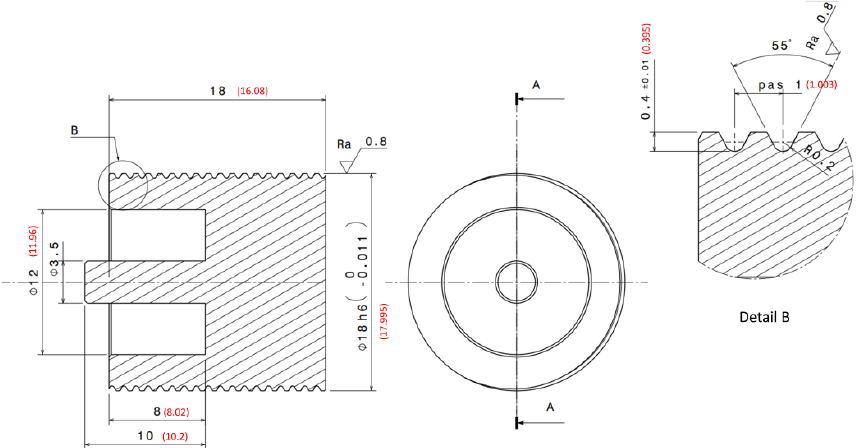
Figure A1. Mechanical drawing of the piston. Parentheses (red) indicate the measured dimensions of the sample.